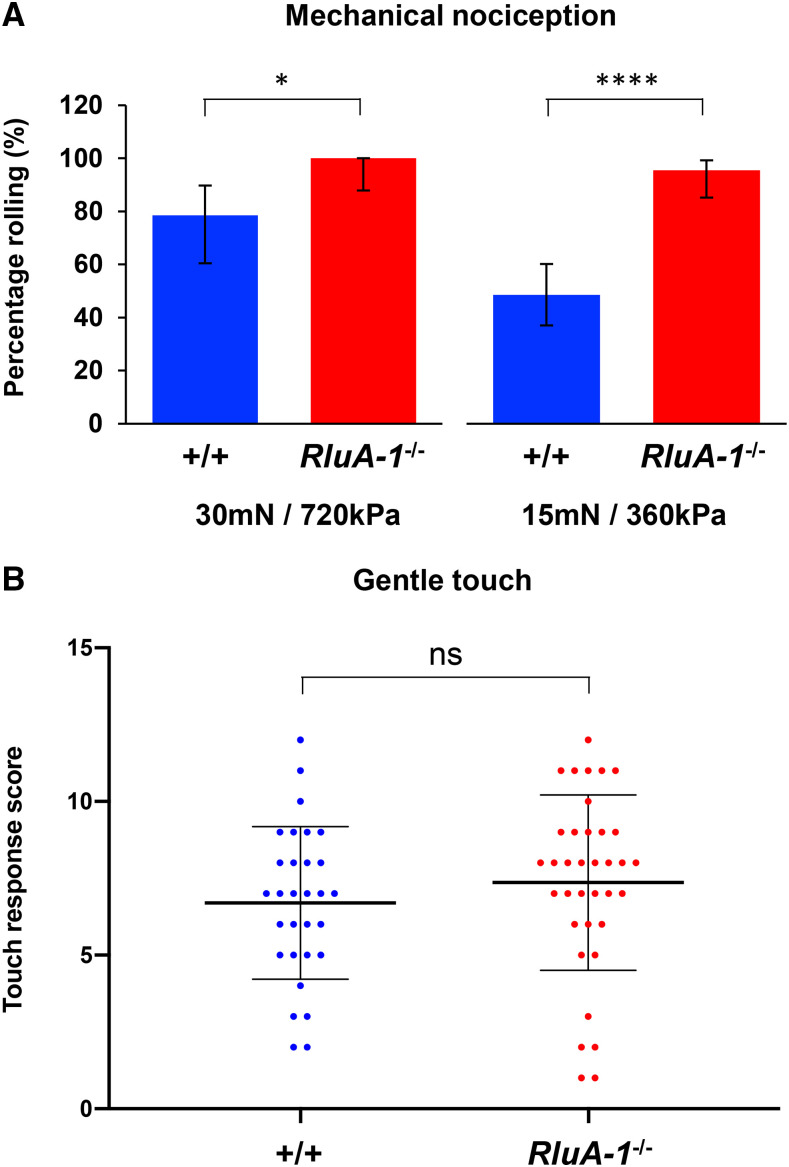
RluA-1 mechanical nociception and gentle touch responses. (A). In response to the noxious mechanical stimulus of 30mN/720kPa, all (100%) of the RluA-1del-HDR null mutant larvae (RluA-1−/−, n = 28) rolled compared to the 78.57% of control larvae (isow1118, n = 28) rolling. At the reduced stimulus of 15mN/360kPa, 95.56% of RluA-1−/− (n = 45) rolled while only 48.53% of control (n = 68) rolled. Significance of the comparisons are marked as *(P < 0.05) and **** (P < 0.0001). Data were analyzed using Fisher’s exact test and presented as percentages ± 95% confidence intervals. (B). RluA-1del-HDR larvae (RluA-1−/−) had a gentle touch response score (6.70 ± 2.48, n = 36) similar to the control larvae (isow1118, 7.83 ± 2.69, n = 30). ns, not significant (P > 0.05). Data were analyzed with Student’s t-test. Error bars represent S.D.